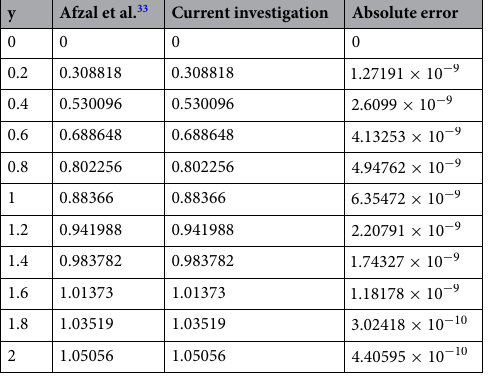
Table 1. Comparison of temperature profile solution with x = 1, m 1 = 0.5, α = 0.5, N TC = 0.8, N b = 0.1, N t = 0.8, N CT = 0.8 .